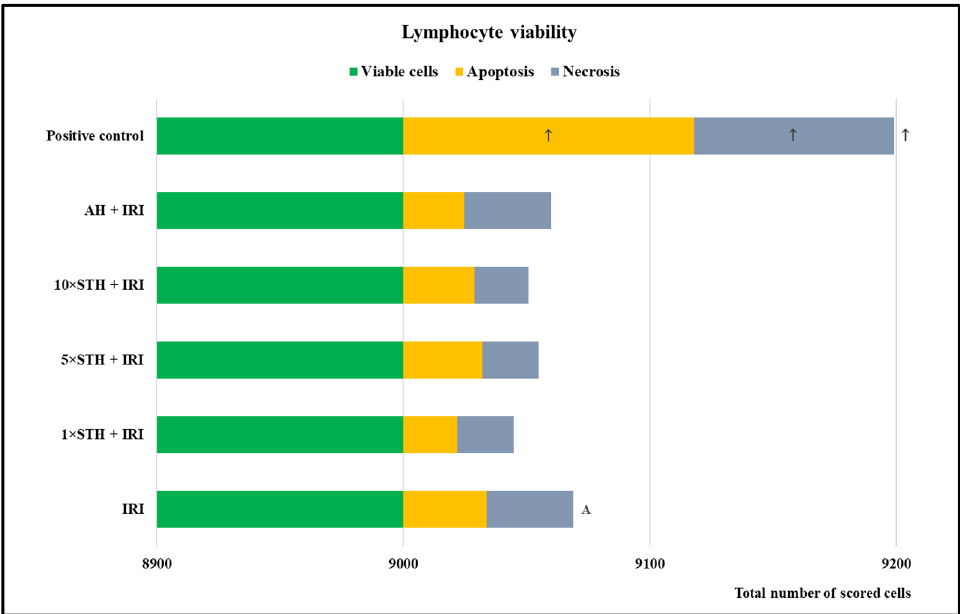
Figure 6. Cell viability effects established after treatment with different combinations of the cytotoxic drug irinotecan (IRI) with strawberry tree honey (STH) and artificial honey (AH). Single-IRI-treated cells and positive control (bleomycin—15 mg/L) cells were studied in parallel. The marks placed inside the categories on the bars refer to the distinct form of cell death (apoptosis or necrosis), while those placed outside the bars denote the total number of non-viable cells. Significantly increased ( p < 0.05) values are ↑ —vs. all other experimental groups; A—vs. 1 × STH + IRI sample.